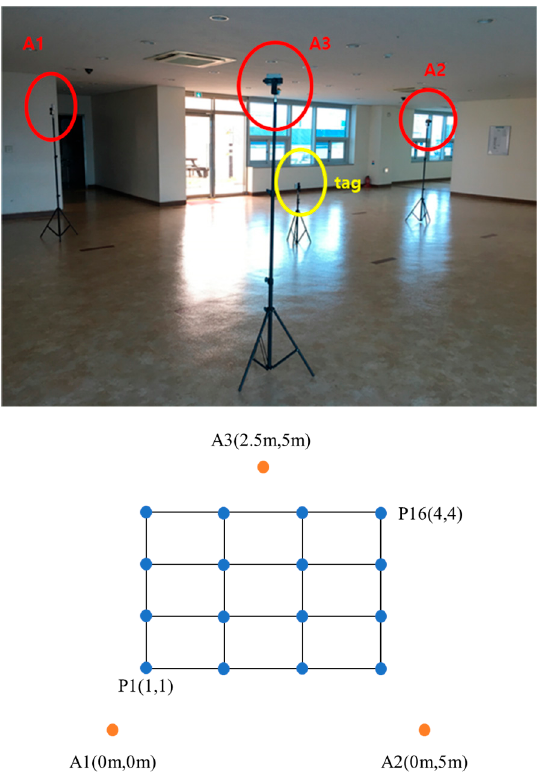
Figure 5. Communication test in indoor and outdoor spaces with a tag (yellow circle) and 3 anchors (red circles).